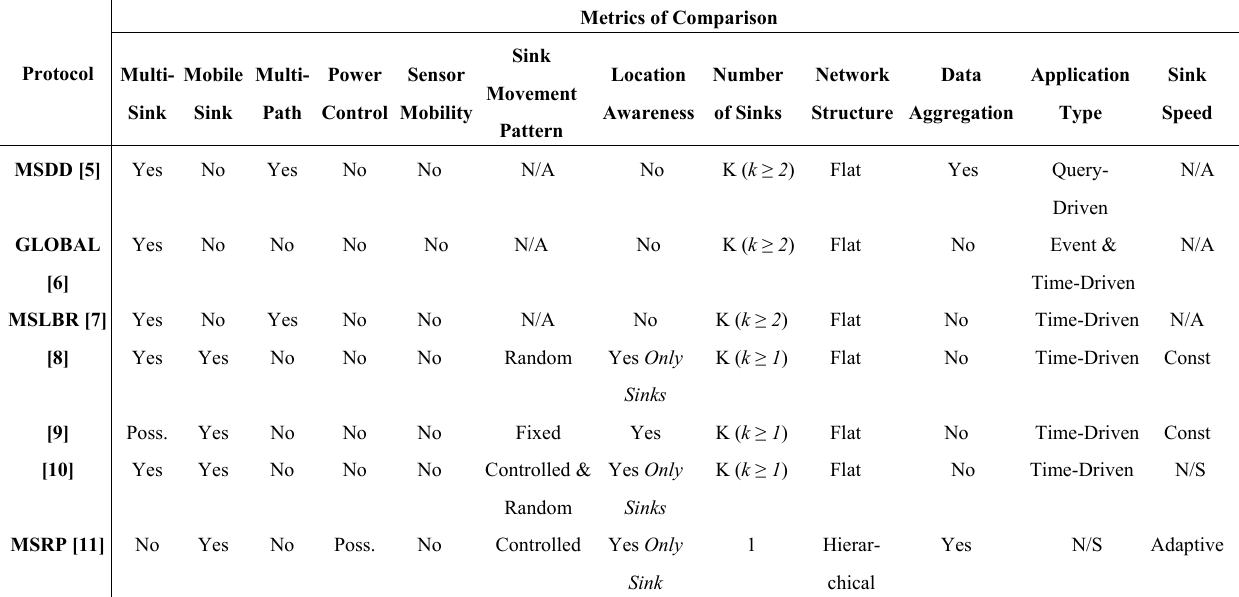
Table 1. Comparison of multi-sink and mobile sink mechanisms.